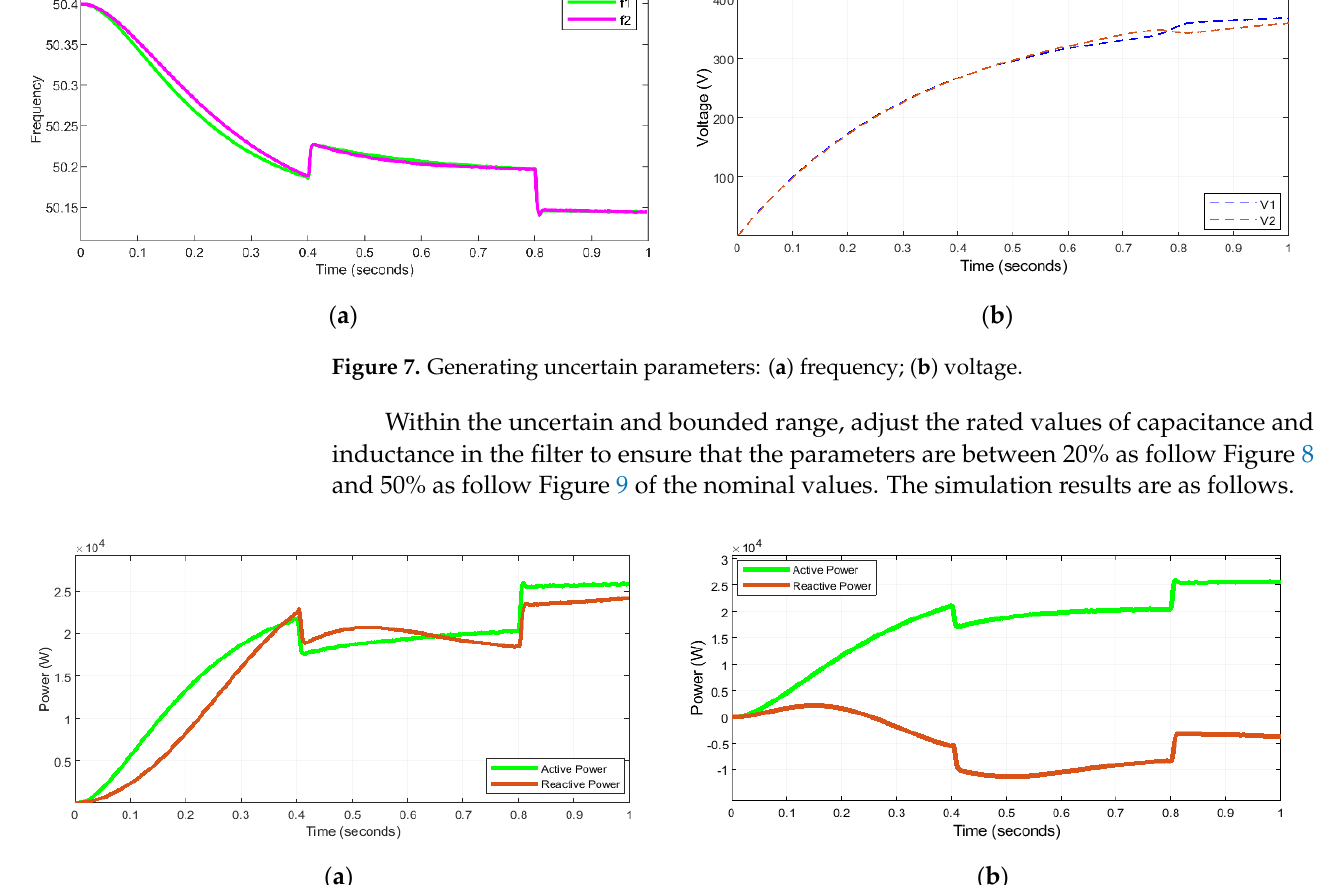
Figure 9. When the parameters change greatly, the output of active and reactive power: ( a ) DG1; ( b )